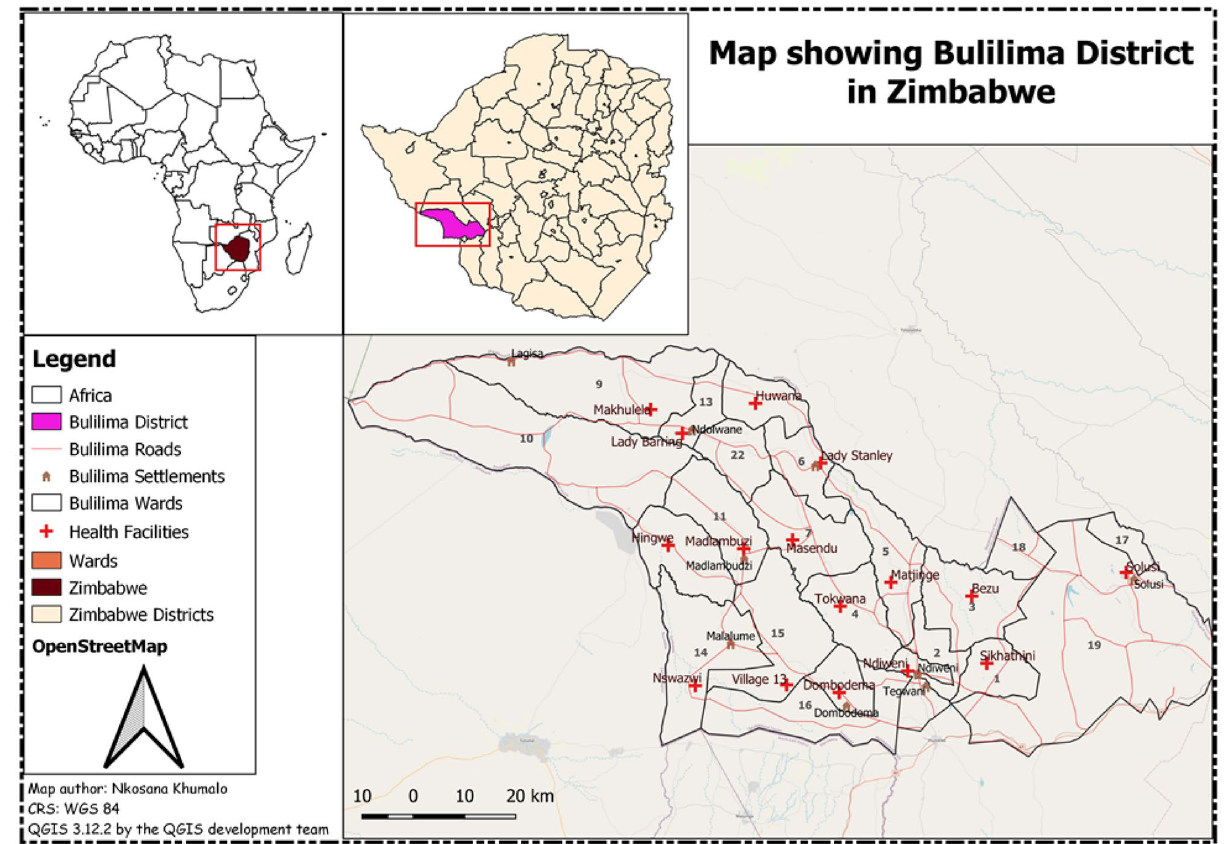
Figure 1. Map showing Bulilima District and its health